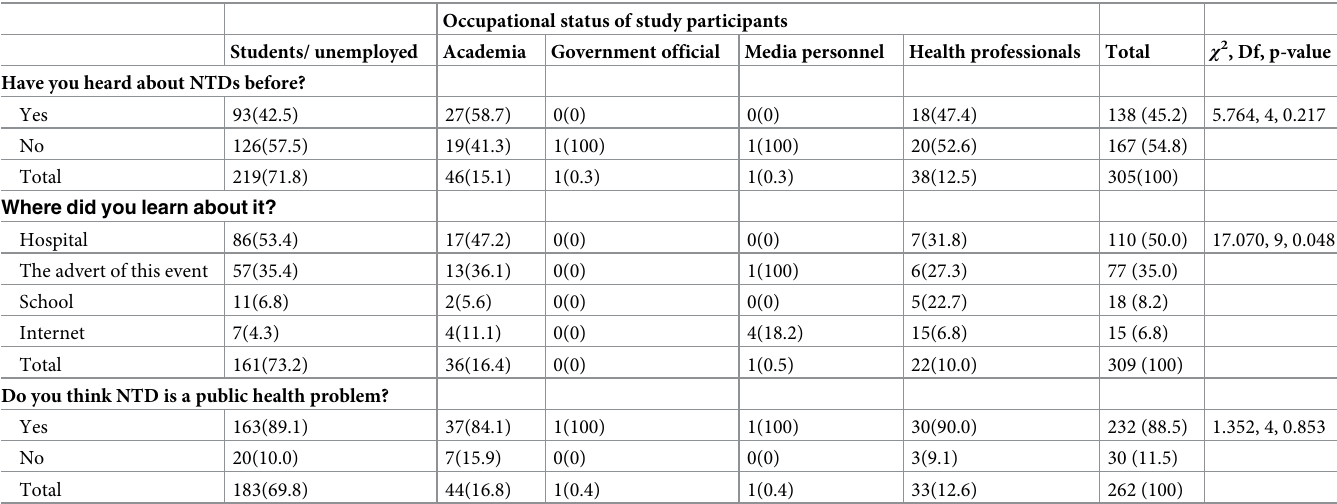
Table 2. Knowledge of study participants about NTDs.